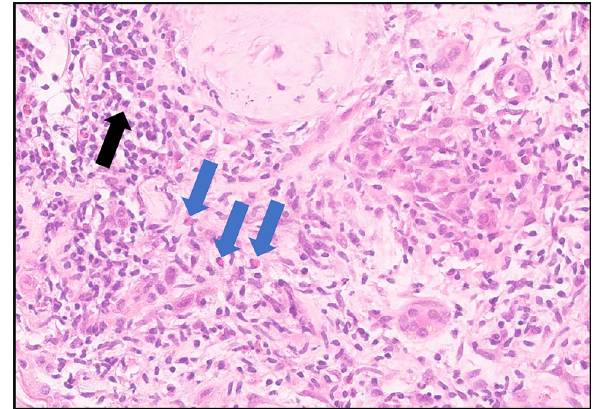
Figure 1. Intersticium dissociated by edema, fibrosis in a lymphocytic inflammatory infiltrate (black arrow) interspersed with eosinophils (blue arrows), present in more than 50% of the